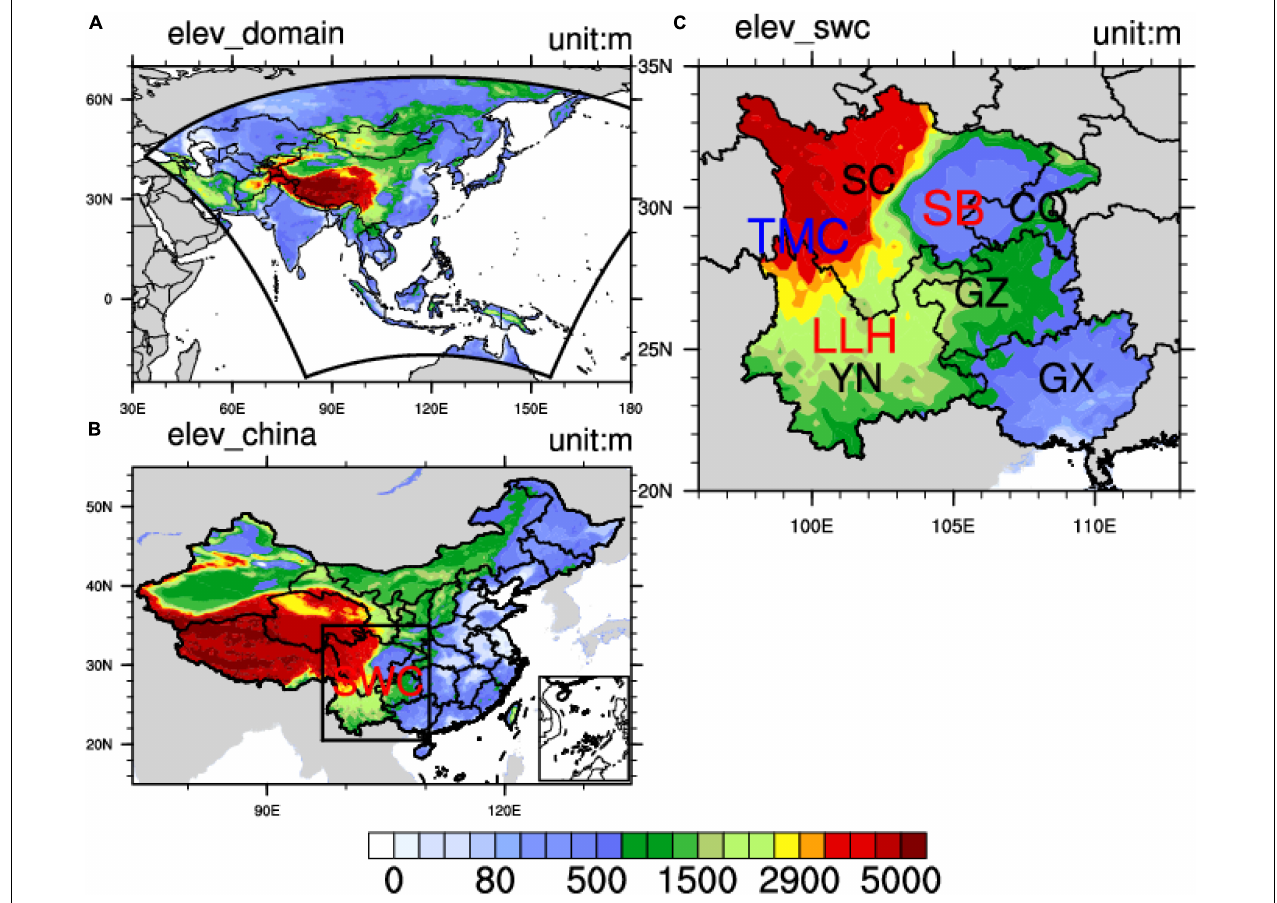
FIGURE 1 | (A) The entire CORDEX East Asia domain (within the outer black line). (B) The analysis sub-region, Southwest China (SWC), with latitudes and longitudes ranging from 21 ◦ N to 35 ◦ N and 98 ◦ E to 112 ◦ E, respectively. (C) Zoomed view of SWC with administrative divisions (black font) and main terrain elements (colored font) marked. Shading indicates topography.